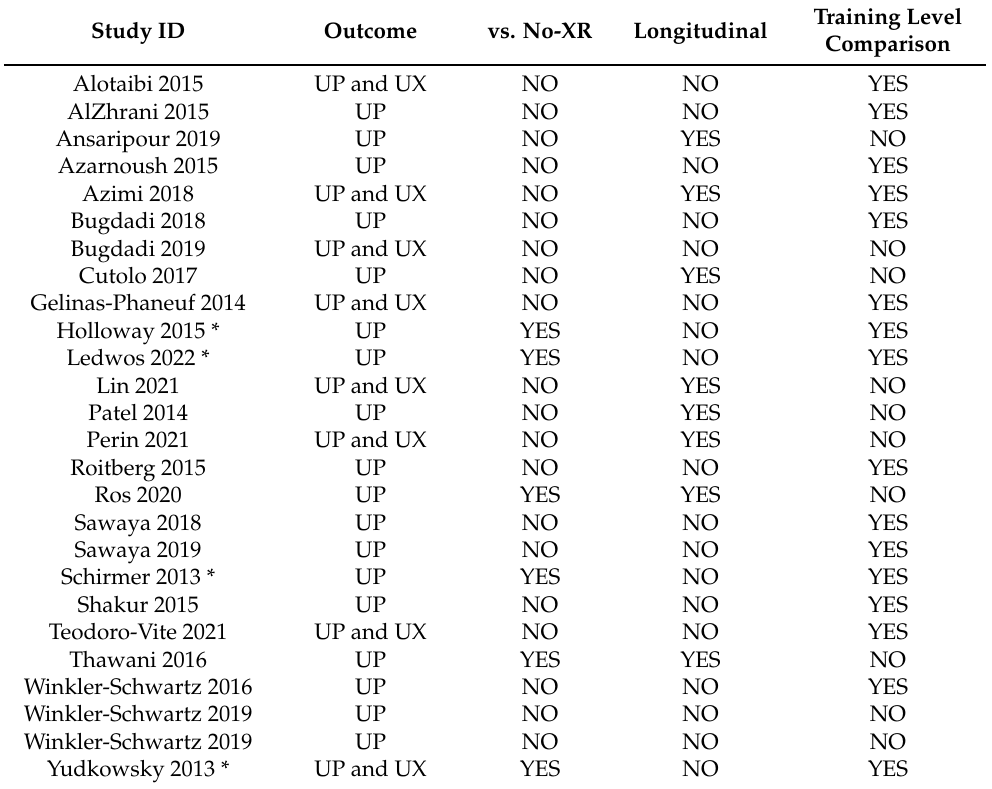
Table 3. User performance. List of studies addressing quantitative metrics of UP, along with related relevant experimental design features. Study ID Outcome vs. No-XR Longitudinal